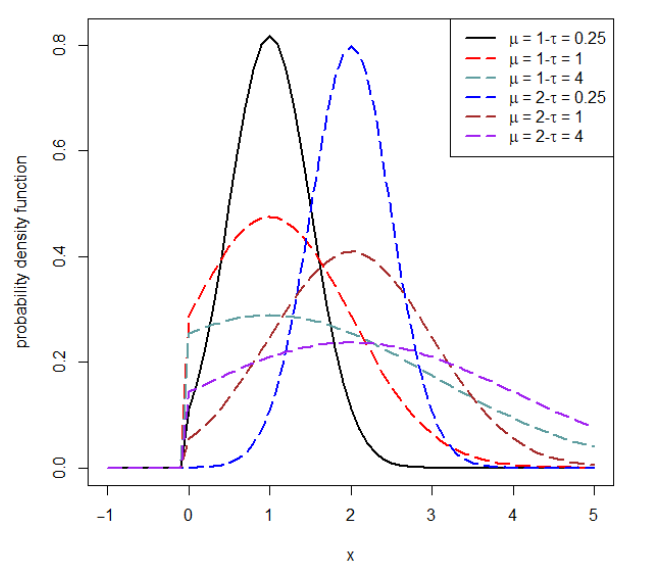
Figure 1. Pdf of truncated normal